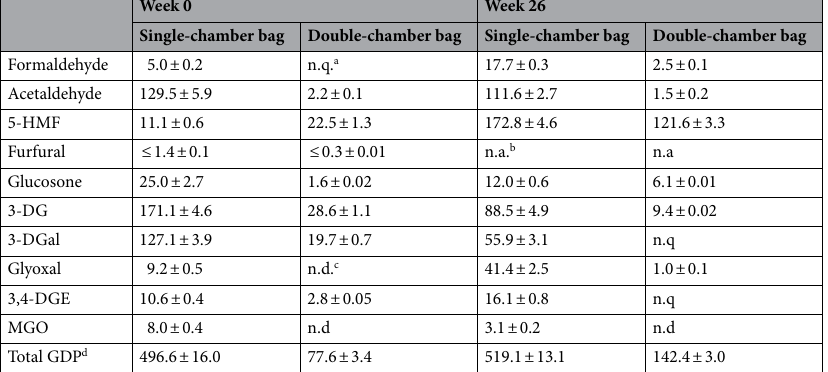
Table 3. Concentration of four monocarbonyl and six α-dicarbonyl GDPs as well as total GDPs in PDFs in µM after 0 and 26 weeks of storage at 50 °C and 45% relative humidity. a n.q., not quantifiable; b n.a., not assessed because of a coeluting compound; c n.d., not detectable, d excluding furfural. Mean values ± standard deviation of three different PDF bags are